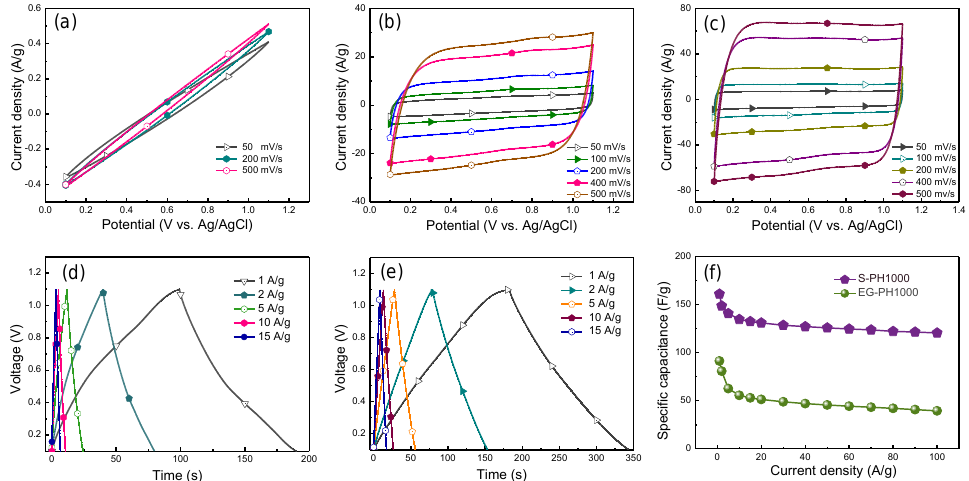
Figure 3. Cyclic voltammetry (CV) curves: ( a ) pristine PH1000 electrodes. ( b ) EG-PH1000 electrodes. ( c ) S-PH1000 electrodes. Charge-discharge profiles: ( d ) EG-PH1000 electrodes. ( e ) S-PH1000 electrodes. ( f ) A graphical representation of the specific capacitance as a function of the current density.